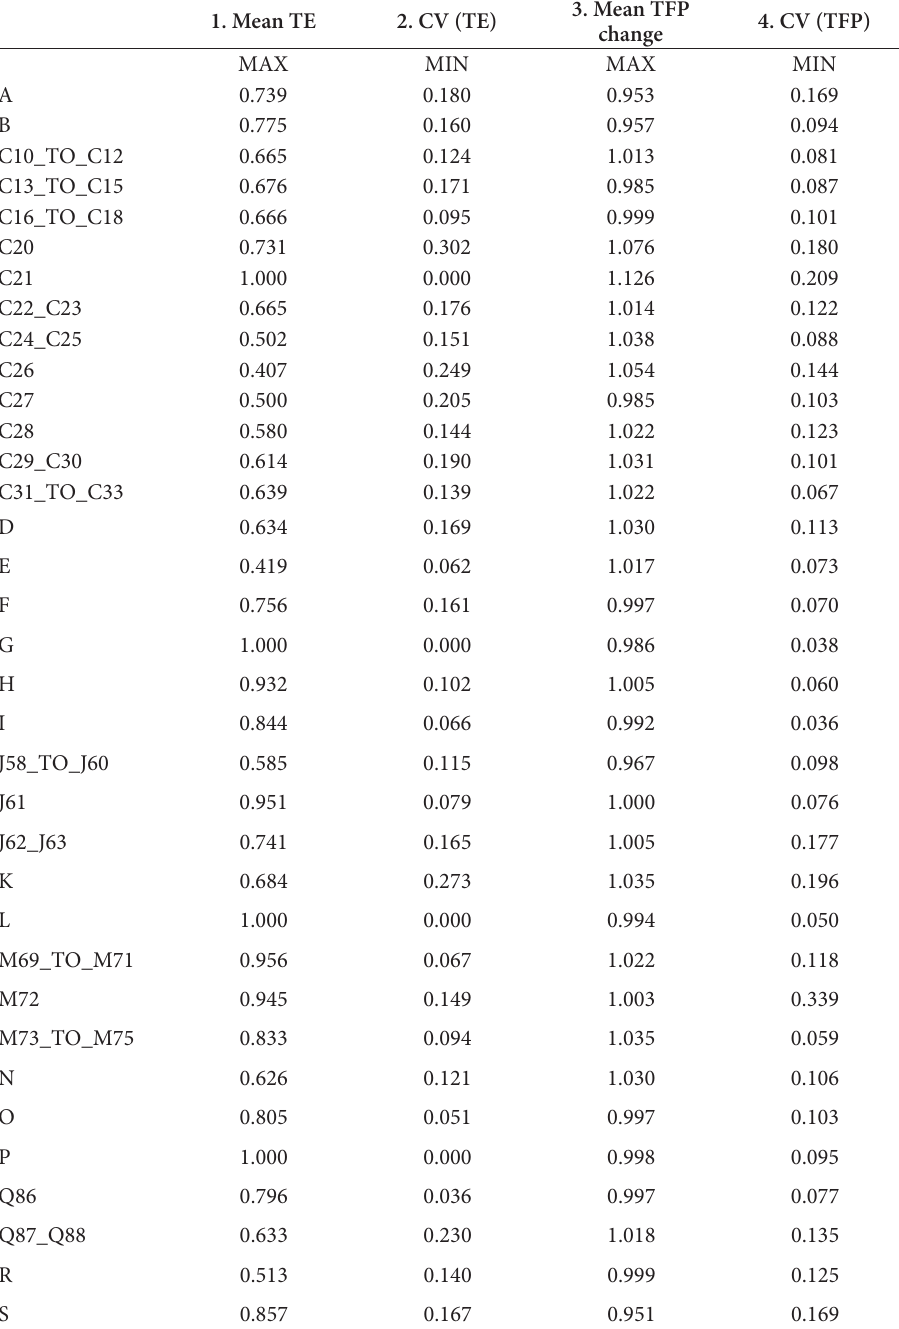
Table A2. Decision matrix for multi–criteria decision